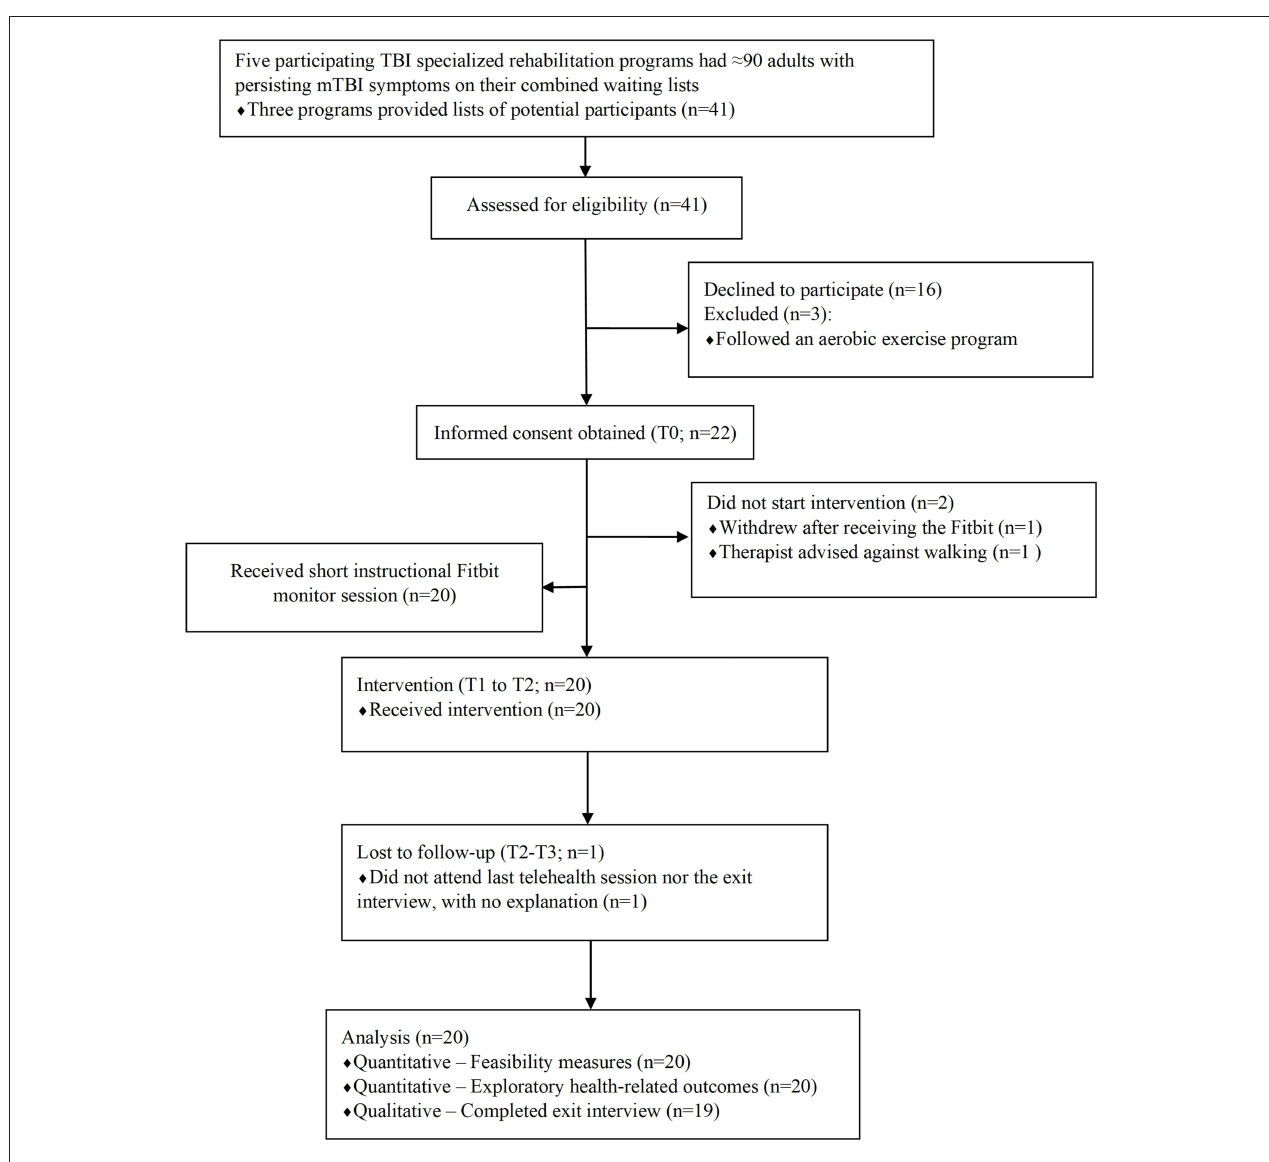
FIGURE 1 | CONSORT diagram of the flow of participants in the